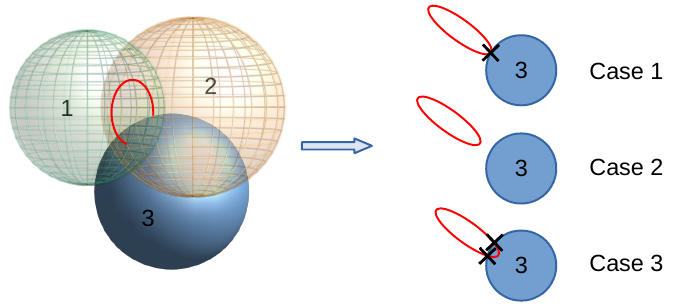
Figure 4. Three different cases for the intersection of three